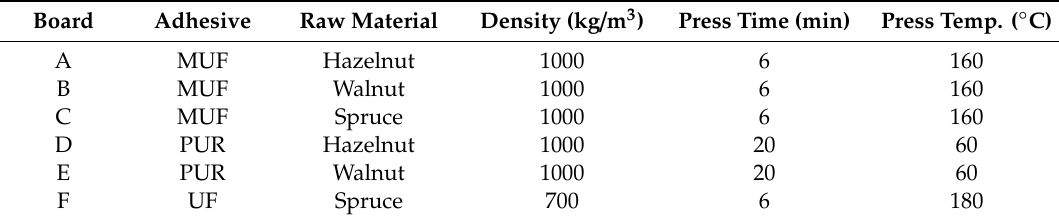
Table 2. Manufacturing parameters of particleboards made from hazelnut, walnut, and spruce.